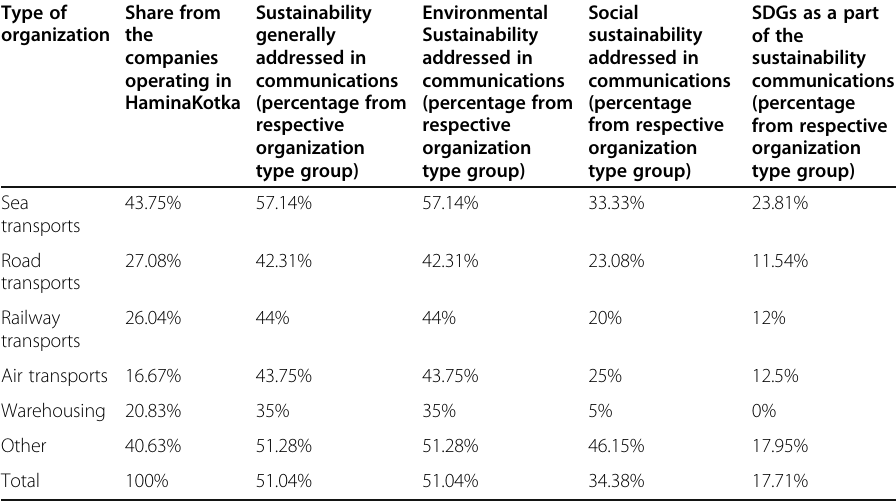
Table 3 Overview of the companies operating in HaminaKotka seaport Type of Share from organization the companies operating